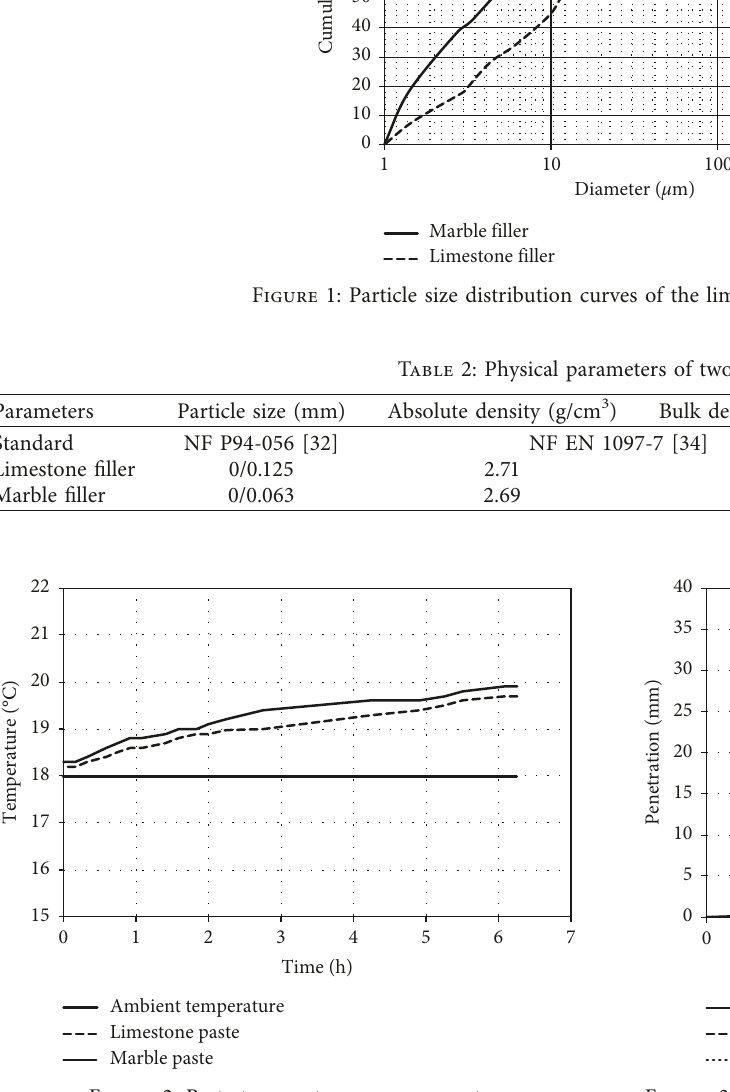
Figure 2: Paste temperature measurement. Figure 3: Measurement of setting time of the different